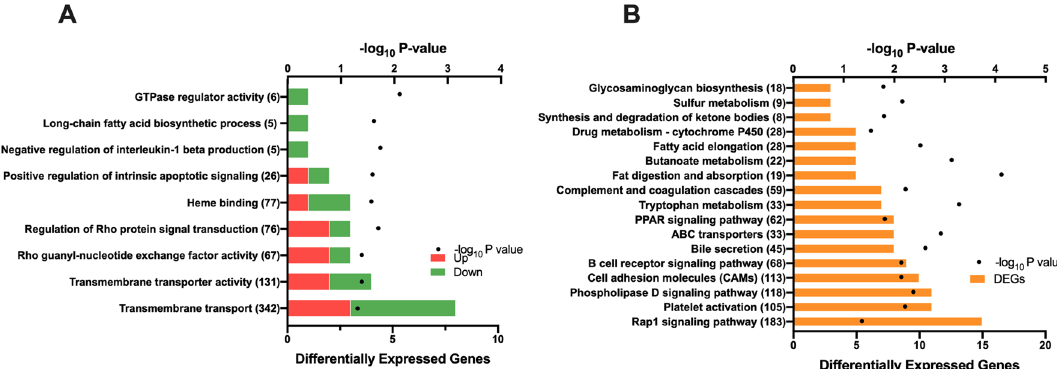
Figure 2. Significantly enriched ( A ) Gene Ontology (GO) and ( B ) Kyoto Encyclopedia of Genes and Genomes (KEGG) 25 pathways in subcutaneous WAT of pre-weaned dairy calves supplemented with 5-hydroxytrytophan (5-HTP, 90 mg/day; n = 4) or saline (CON, 8 mL saline; n = 4) for 10 consecutive days. The y-axis displays the names and total number of genes in each pathway/term, and the x-axis displays the number of differentially expressed genes (DEGs) within each pathway/term and the significance of enrichment (− log10 P-value). Red and green bars display the number of upregulated and downregulated DEGs in the 5-HTP group; orange bars display the number of DEGs.